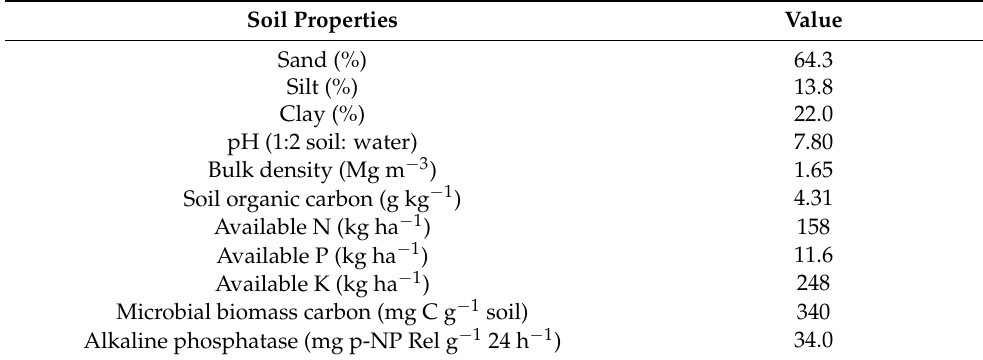
Table 1. Initial soil properties of the experimental